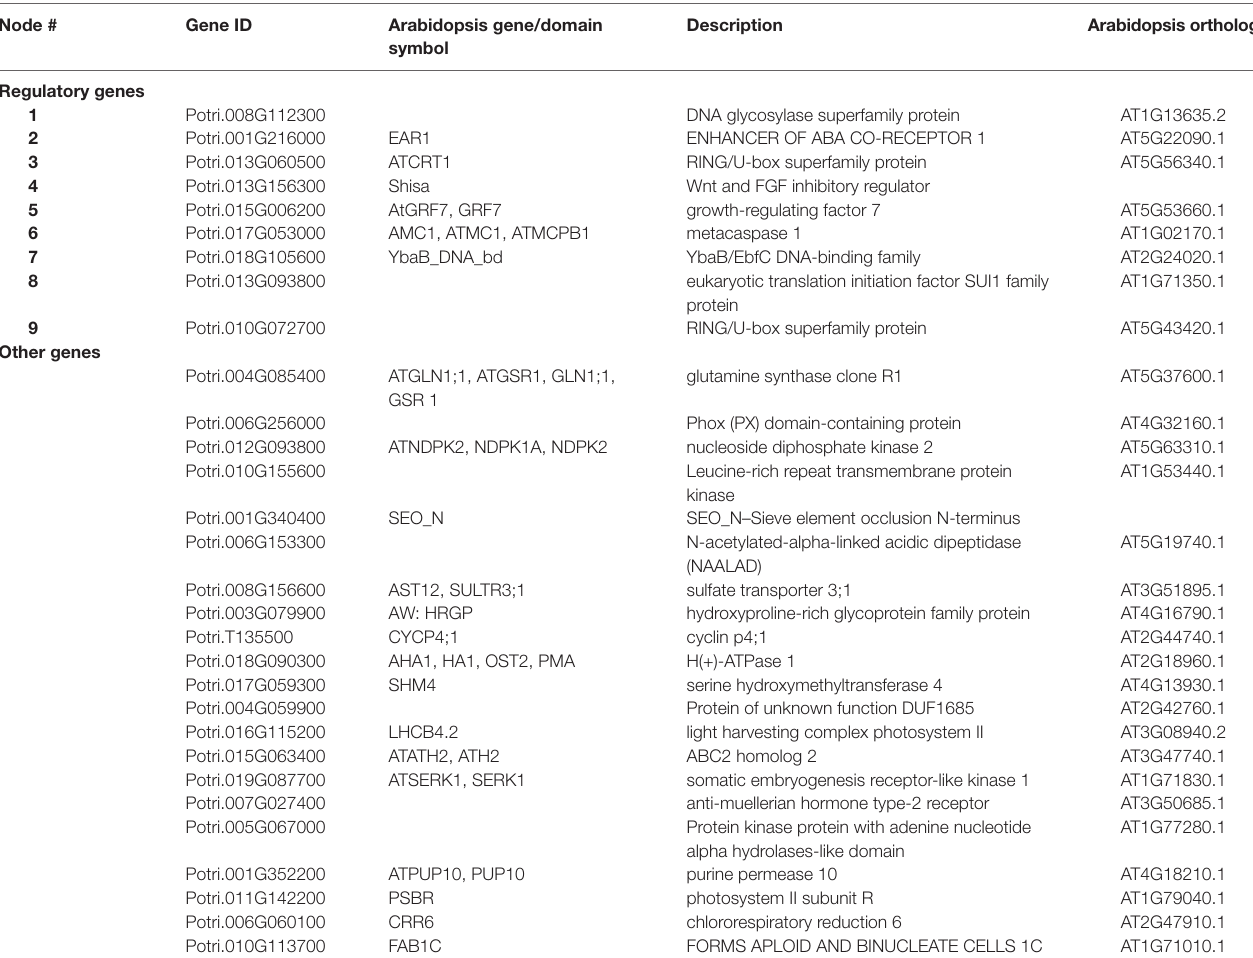
TABLE 1 | Tier 1 high LOE genes. See Supplementary Table S9 for additional score and annotation information. Node